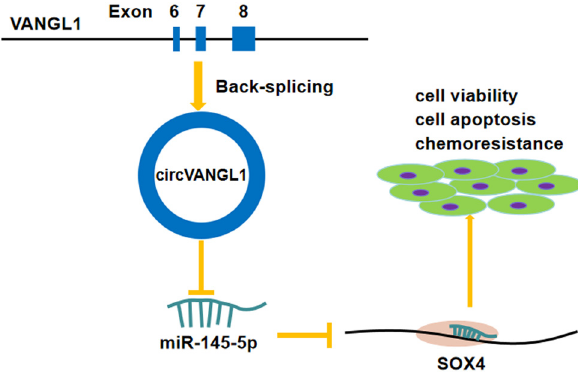
Figure 8: Schematic diagram indicates the regulation of circ_VANGL1/miR - 145 - 5p/SOX4 axis in bladder